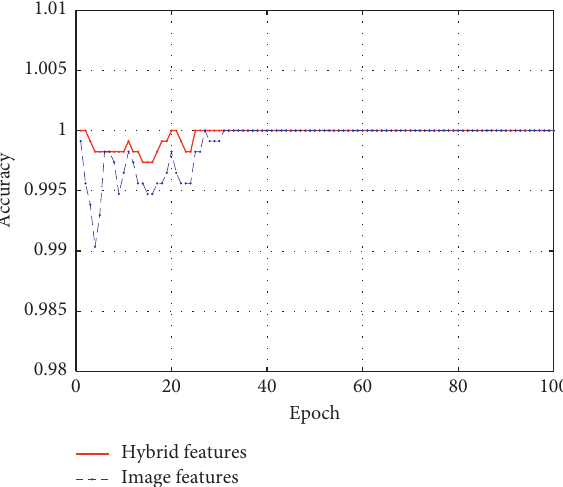
Figure 11: Recognition rate of SVM on different